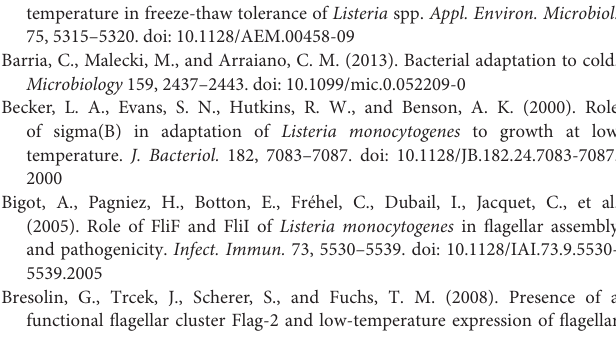
FIGURE S1 | Generation time (Gt) distribution at 8 and 30 ◦ C. Black circle and gray bars correspond to data from 8 and 30 ◦ C, respectively (data in Supplementary Table S1 ). FIGURE S2 | Pulse field gel electrophoresis (PFGE) of L. monocytogenes strains classified as fast and slow growth at low temperature (8 ◦ C). Black squares mark strains selected for global gene expression analysis. Details of the strains in Supplementary Table S1 . FIGURE S3 | Differentially expressed genes shared between fast and slow groups in response to low temperature grouped by COGs. The genes were classified into 20 COGs based on their predicted function (COG details in Figure 2 ). TABLE S1 | Characteristics of the L. monocytogenes strains used in the study. Generation time (Gt) at 8 and 30 ◦ C. The lowest 5% and highest 5% of values of Gt were classified as Fast and Slow strains respectively. TABLE S2 | Microarray data analysis. Green represents down-regulated genes and red represents up-regulated genes. TABLE S3 | Primers used in the